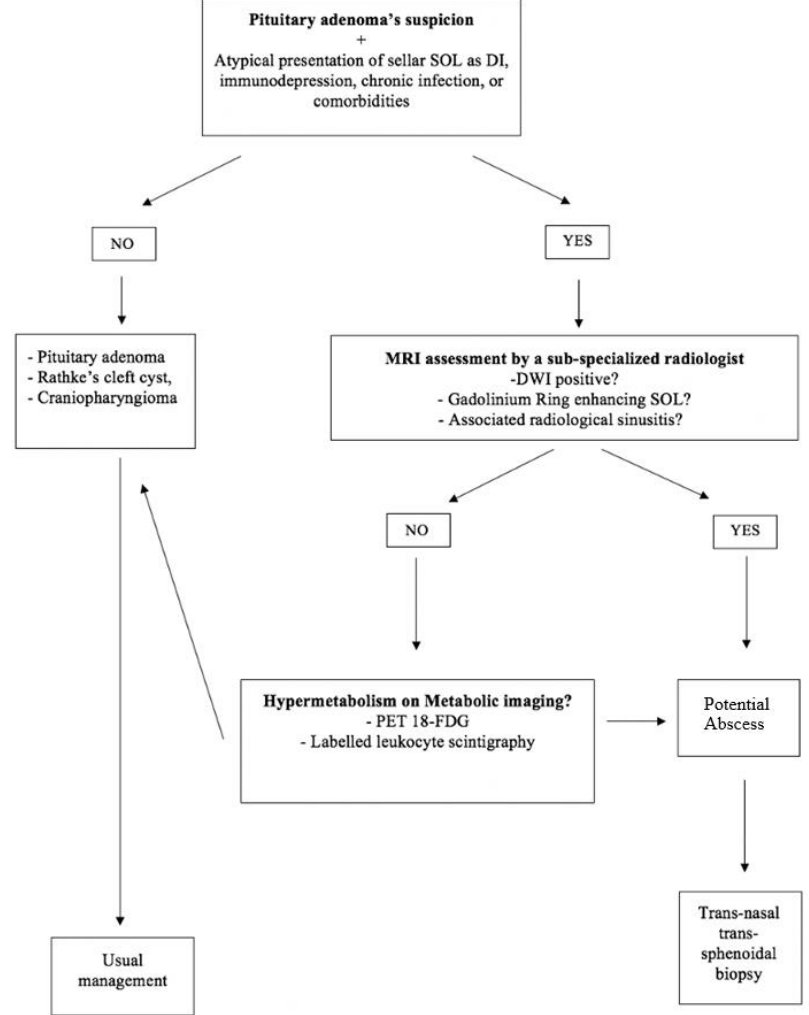
Figure 2. Algorithm for clinical decision-making process in lesions diagnosed as PAs. SOL: space occupying lesion; MRI: Magnetic Resonance Imaging; DI: Diabetes Insipidus; DWI: Diffusion Weighted Images; 18 FDG PET: fluorodesossiglucose positron emission tomography.